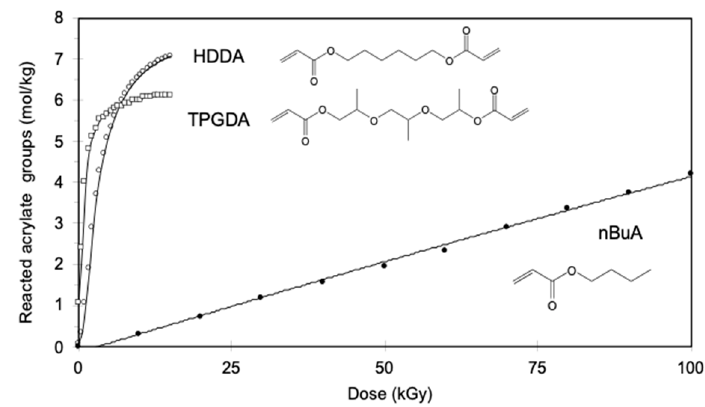
Figure 2. Kinetic profiles of acrylate consumption in monomer films as a function of EB radiation dose (nBuA ( ● ), tripropyleneglycol diacrylate (TPGDA) ( ☐ ) and hexanediol diacrylate (HDDA) ( ○ ).